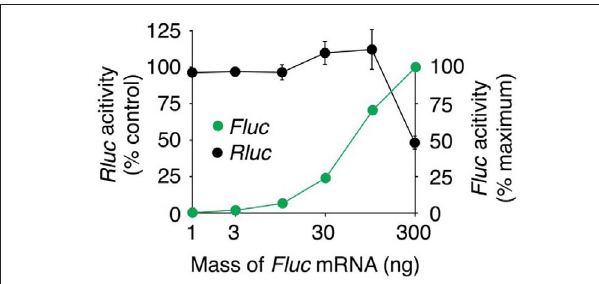
Figure S2 | effect of expression of an additional coding mrNA on Rluc expression. Expression of Rluc and an additional protein (Fluc) was measured simultaneously in lysates from DRG neurons transfected with 100 ng of Rluc mRNA and 1–300 ng of Fluc mRNA. Cells were incubated with transfection mix containing the mRNA and 0.24 μl L2K for 1 h. Rluc and Fluc activities were measured 16 h after transfection using the Dual Luciferase Reporter Assay System. Rluc activity (•) was normalized to the luciferase activity of cell lysates transfected with 100 ng Rluc mRNA alone. Fluc activity (•) was normalized to the maximum Fluc activity within an experiment (n = 3 ). The same Ruc activity is presented in Figure 1vi